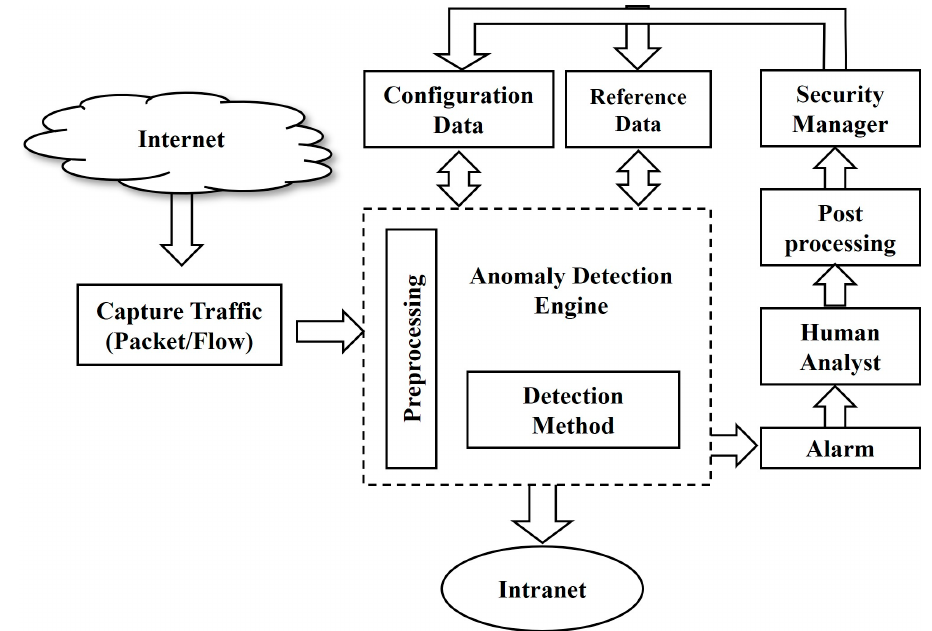
Figure 1. A Generic architecture of ANIDS.